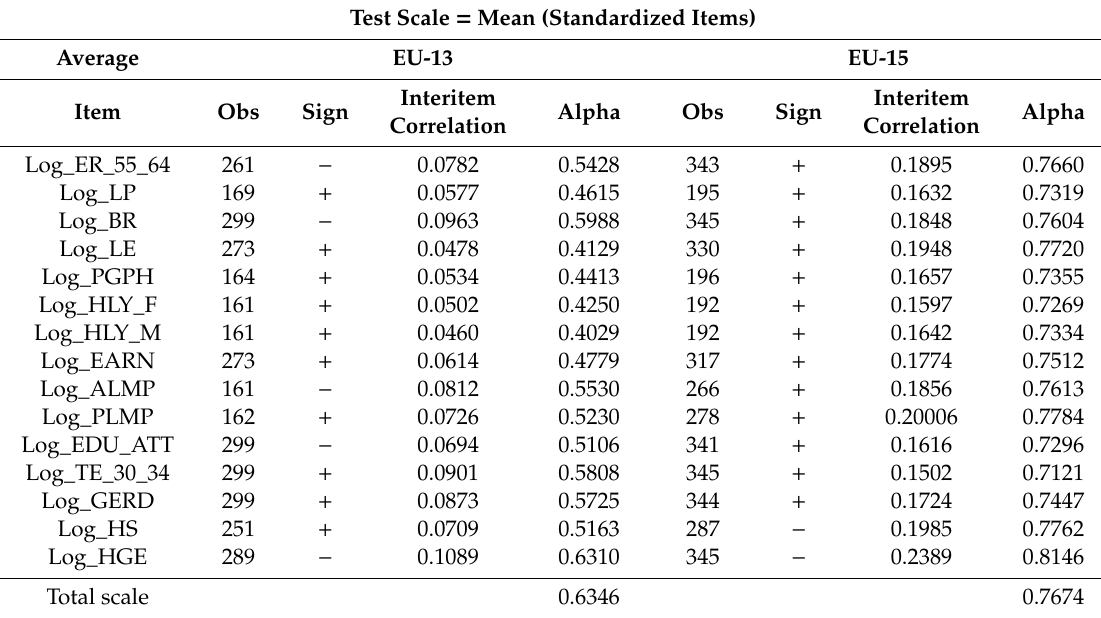
Table A3. Cronbach’s alpha for the SEM models, EU-13 and EU-15, 1995–2017. Test Scale = Mean (Standardized Items)